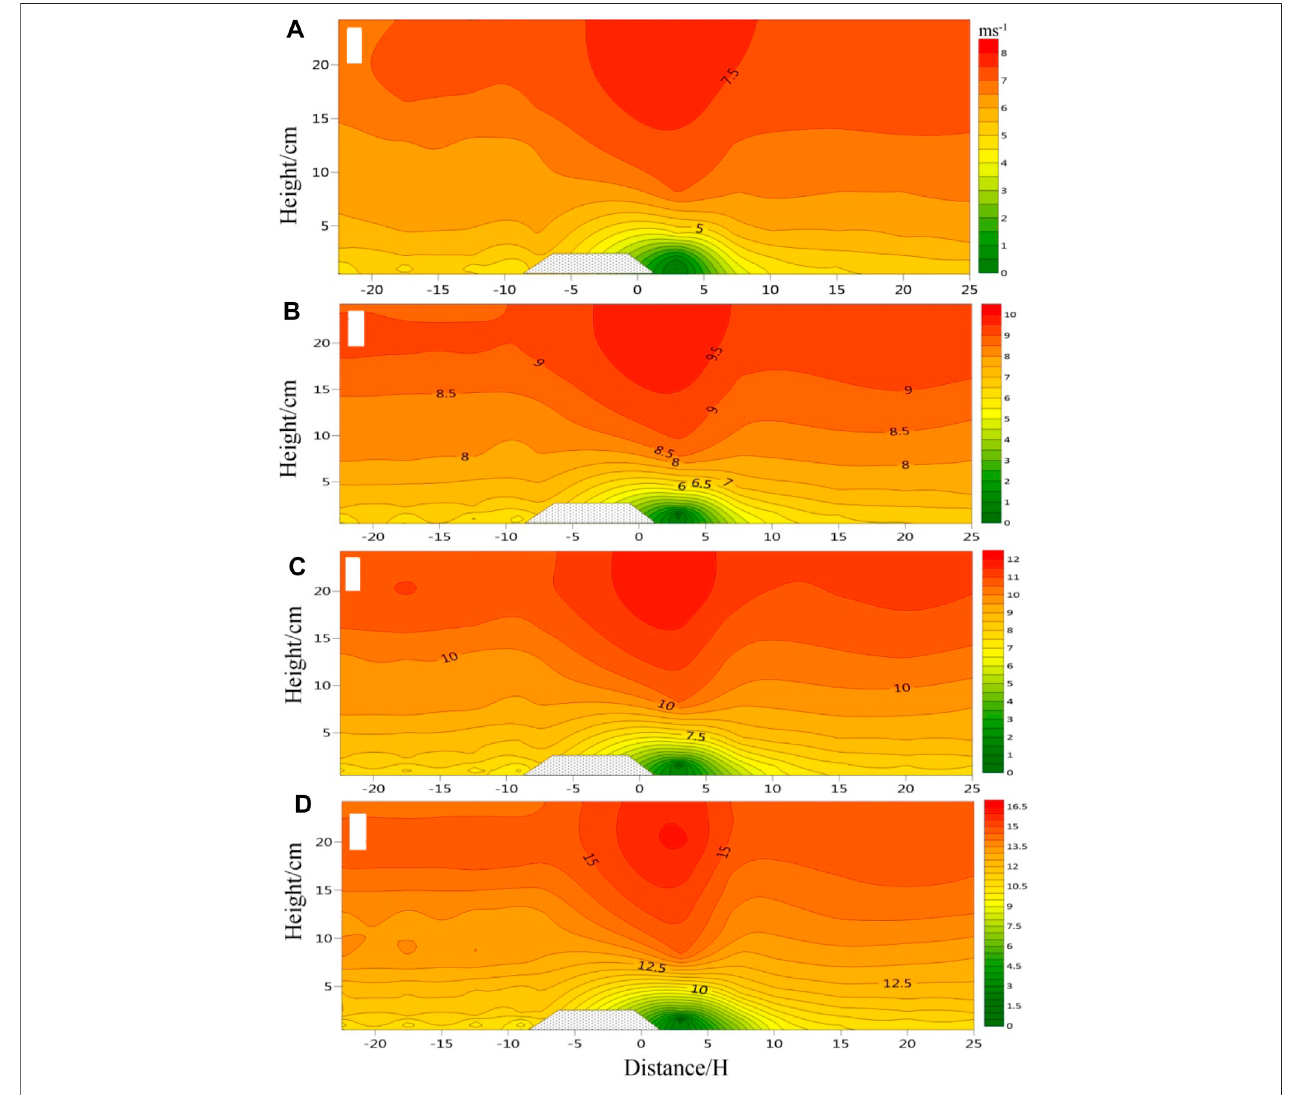
FIGURE 9 | Flow fi eld around the subgrade at 6, 8, 12, and 16 m s − 1 wind speeds (A) 6 m s − 1 ; (B) 8 m s − 1 ; (C) 12 m s − 1 ; and (D) 16 m s − 1 .